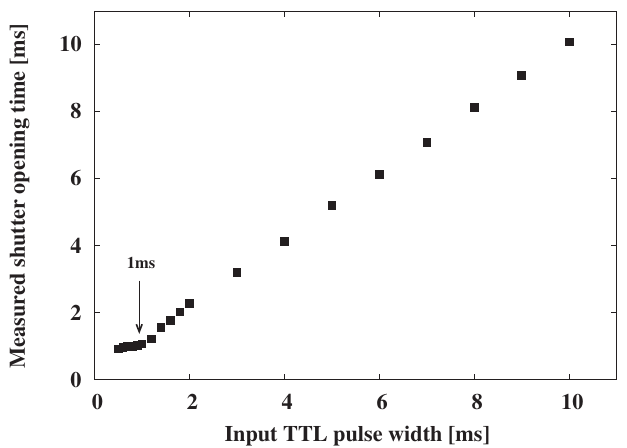
FIG. 8. Measurement results of the shutter opening time in the NORMAL mode. The horizontal axis shows the input TTL pulse width into the shutter controller. The vertical axis shows the full- width half maximum of the measured pulse width detected by the